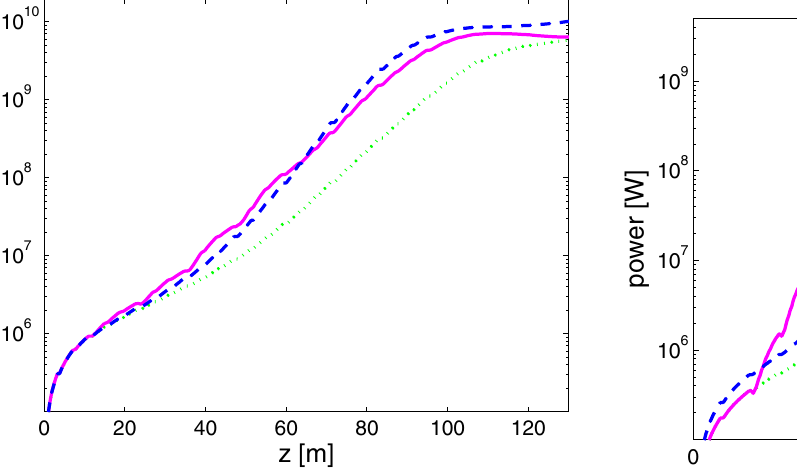
FIG. 7. (Color) SASE FEL power along the undulator at the normalized emittance of 1 : 5 (cid:8) m without any optical klystron (green dotted curve) and with 4 optical klystrons (magenta solid curve), and at the emittance of 1 : 2 (cid:8) m without any optical klystron (blue dashed curve). FEL wavelength is 1 : 5 (cid:1)A , the undulator parameter K is 3.5, and the initial electron rms energy spread is 5 (cid:9) 10 (cid:2) 5 .